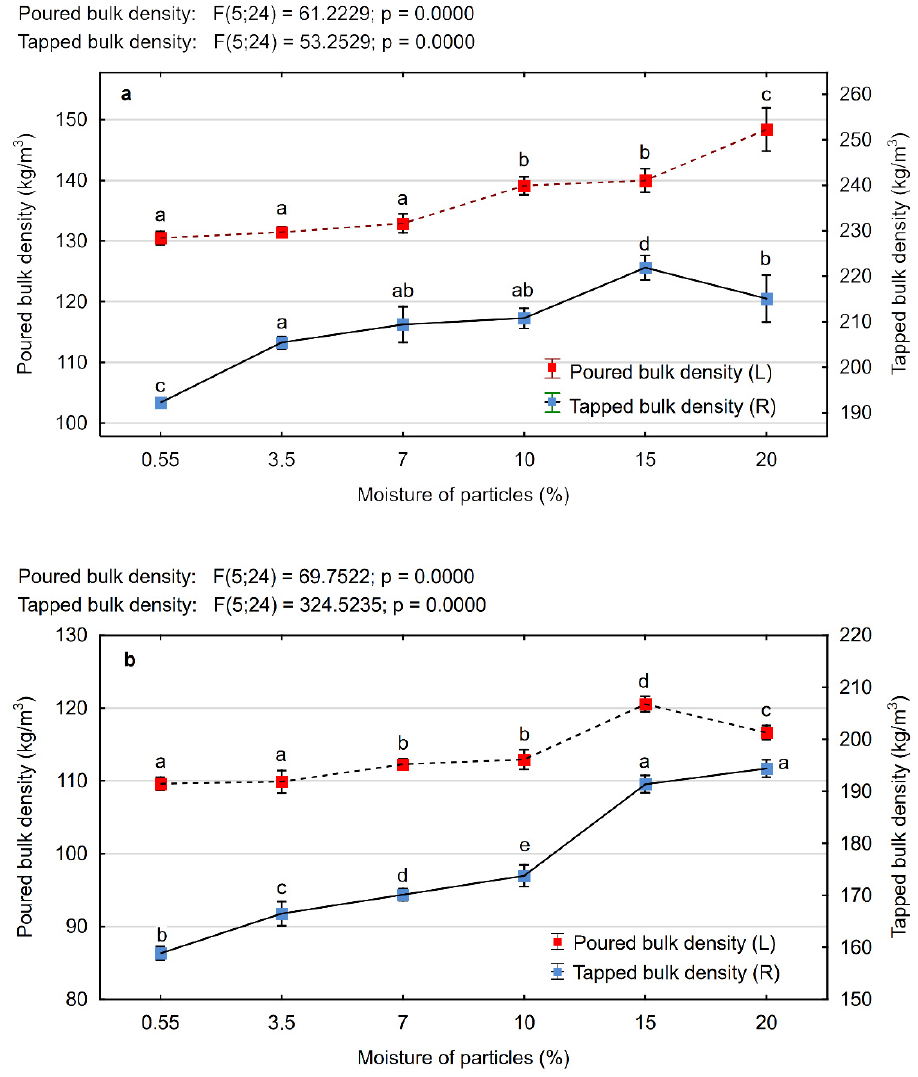
Figure 5. Poured bulk density and the tapped bulk density of microparticles ( a ) and wood particles of the core layer of particleboard ( b ) depending on their moisture content (a, b, c …—homogeneous groups as determined by the Tukey test).